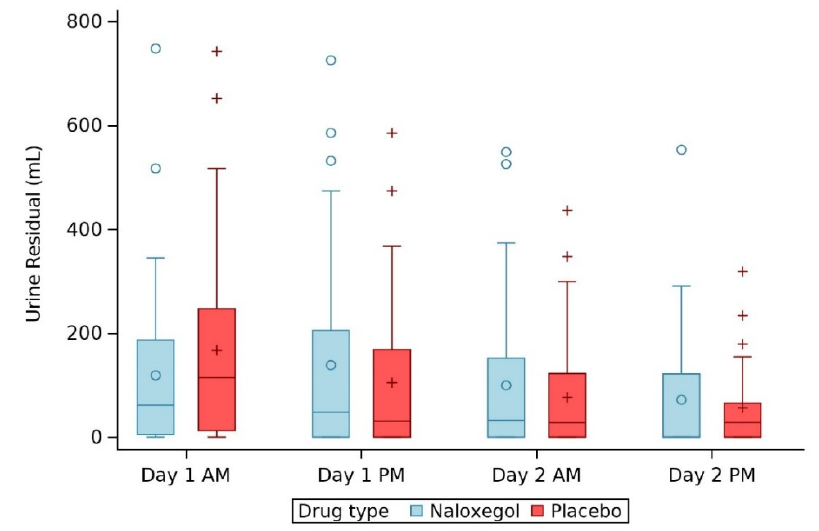
Figure 2. Boxplot of urine residual by time. The line in the box represents the median of each group. The blue circle in the box represents the mean of urine residual in naloxegol group and blue circles outside the box represent the outliers. The red “+” sign in the box represent the mean of urine residual in placebo group and red “+” sign outside of box represent outliers.